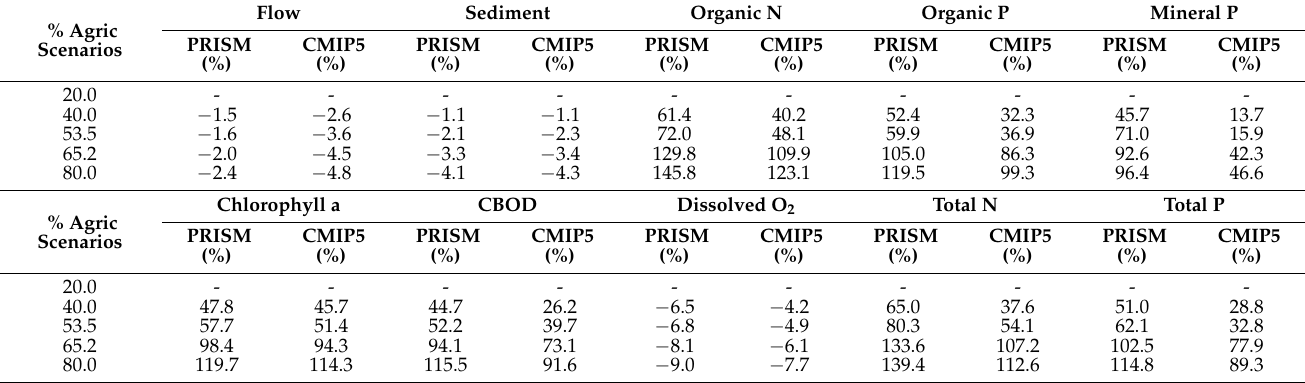
Table 4. Percentage change in simulated variables relative to the 20% agriculture